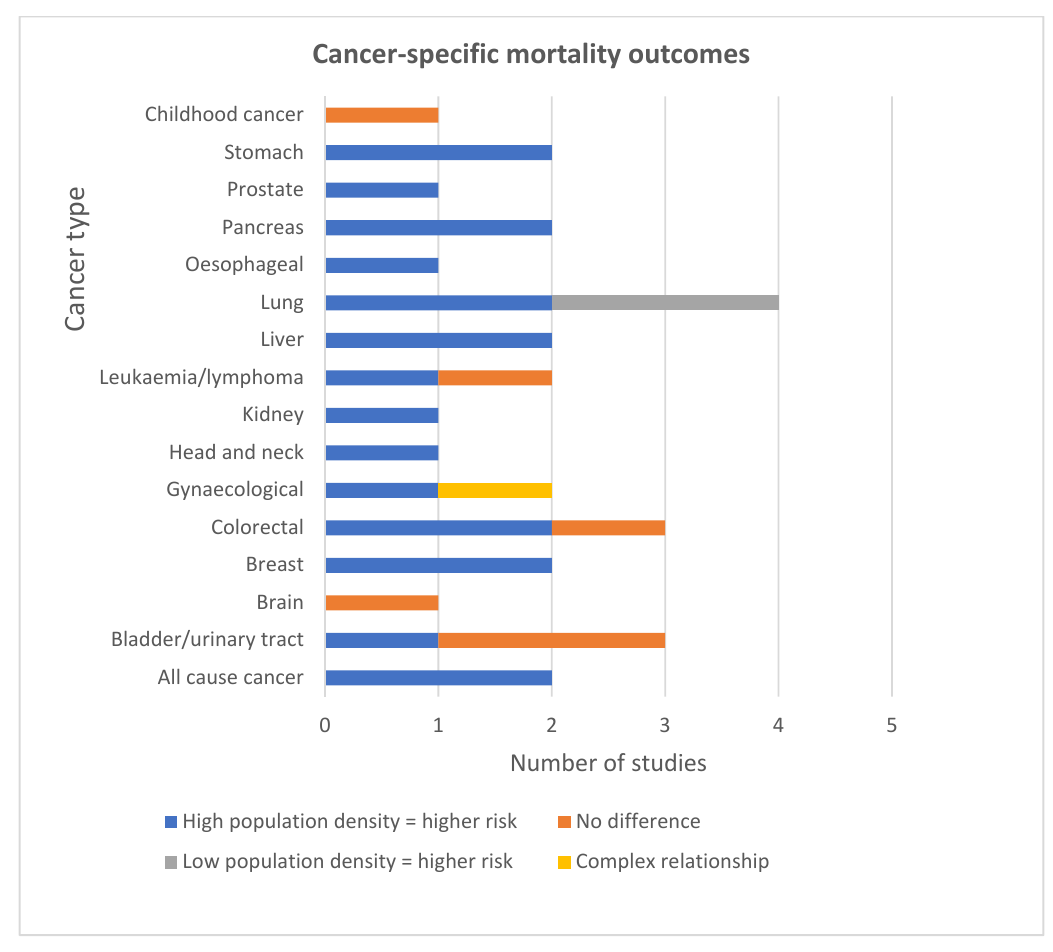
Figure 4. Cancer-specific mortality outcomes.